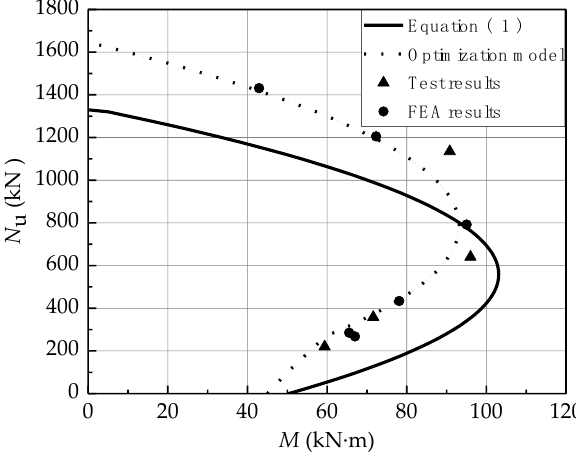
Figure 11. Ultimate load – bending moment curve.